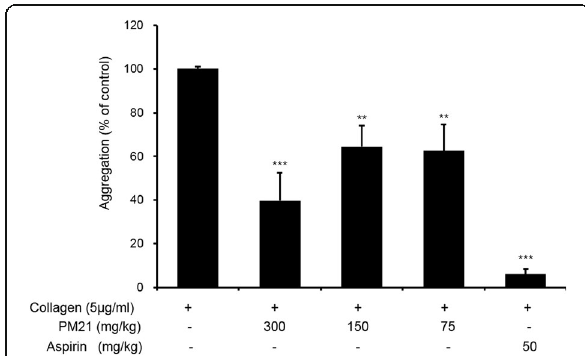
Fig. 1 Ex vivo effects of PM21 (a 2:1 mixture of bamboo leaf extract and Japanese apricot fruit extract) on platelet aggregation. Six male rats in each experimental group were treated with test samples. PM21 was orally administered daily after overnight fasting for 3 days to three test groups at the doses of 75 mg/kg, 150 mg/kg, and 300 mg/kg, and aspirin was administered to positive control group at the dose of 50 mg/kg. Blood was collected 1 h after the final treatment. Platelet aggregation was induced by adding 5 μ g/mL collagen and terminated after 5 min, and monitored by measuring light transmission with an aggregometer. Data show the mean±SEM of six measurements. ** p <0.01, *** p <0.001 versus vehicle control